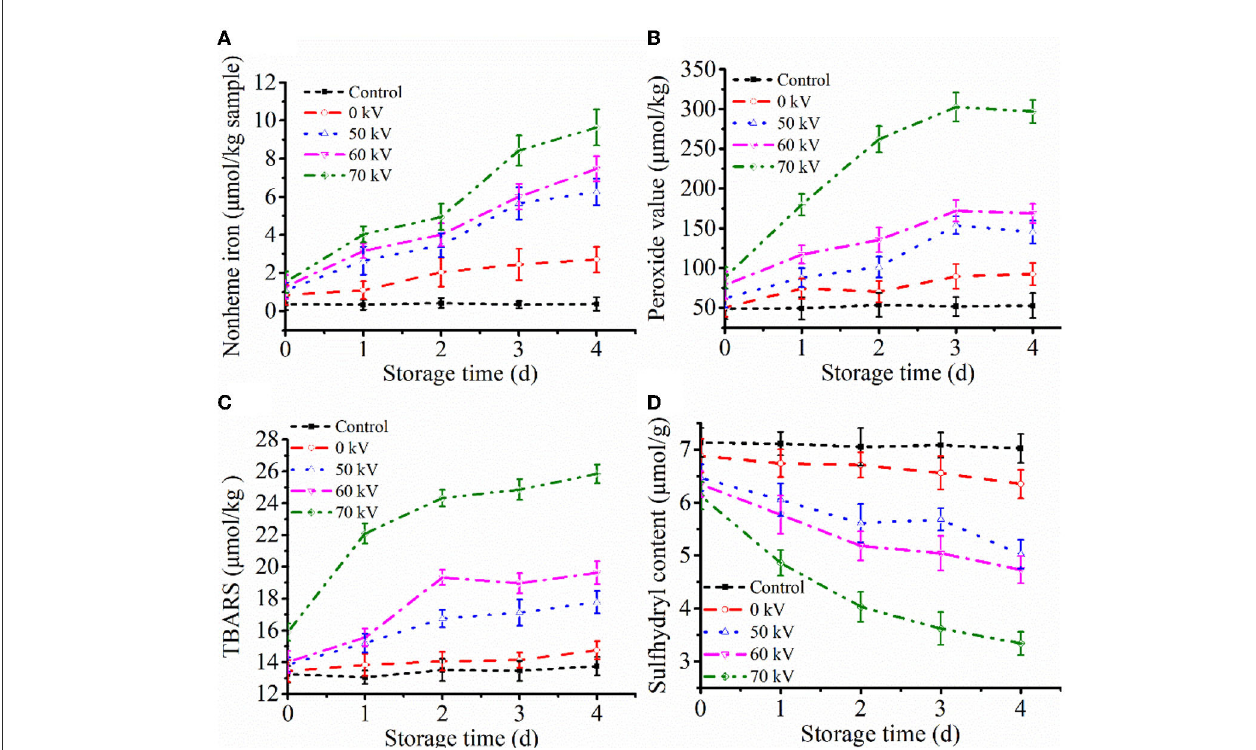
FIGURE1 Profiles of (A) non-heme iron contents, (B) peroxide value (PV), (C) thiobarbituric acid reactive substances (TBARS), and (D) total sulfhydryl group content (T-SH) of washed pork muscle added without and with added Mb at pH 7.0 after treatment by DBD-CP at 4 ◦ C for 4 days. Control, washed pork muscle; 0 kV, washed pork muscle added Mb; The remaining groups were treated by DBD-CP at 50, 60, 70 kV for 180s, respectively; The operating frequency was 50Hz. Replicates per treatment were n = 3. Means and standard deviations are